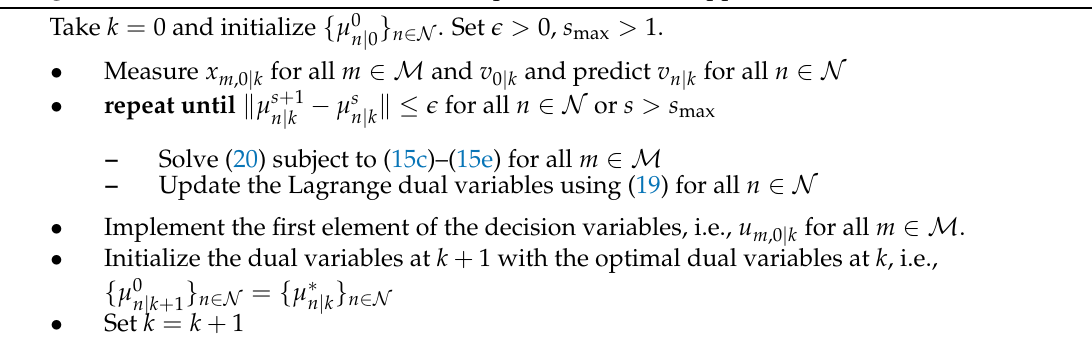
Algorithm 1: Distributed economic model predictive control approach for